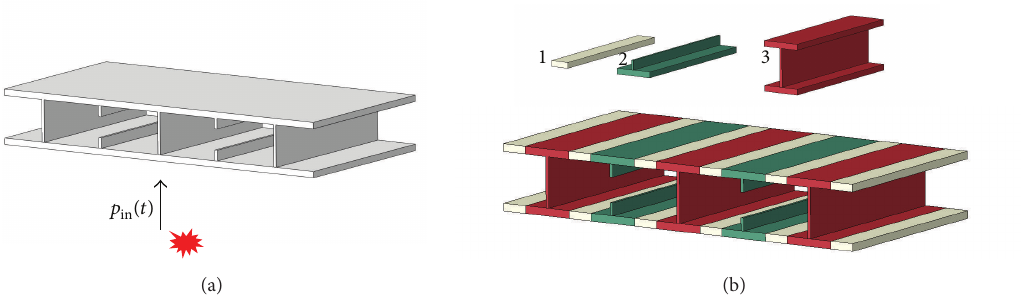
Figure 1: Sketches of problem geometry for double-bottom structure: (a) typical double-bottom structure to underwater blast; (b) three substructures for the double-bottom structure.